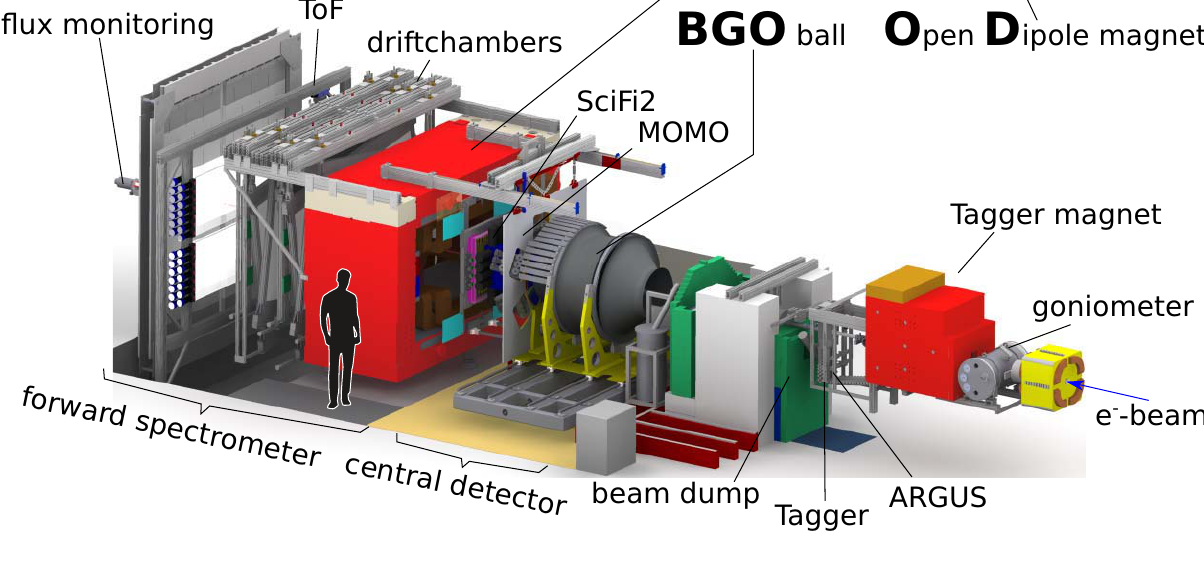
Figure 3. The BGO-OD experiment